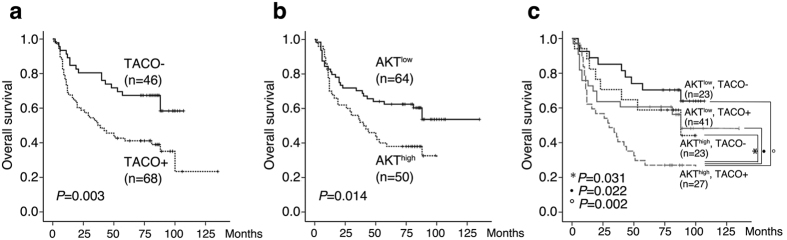
Association between postoperative survival, intrahepatic HBV CP mutations and pAKT levels.(a) Comparison of survival between patients with and without TACO mutations. (b) Comparison of survival between patients with different levels of pAKT. (c) Combination of intrahepatic TACO mutations and pAKT as a predictor for overall survival. TACO−: Negative for TACO; TACO+: Positive for TACO; AKTlow and AKThigh: low or high levels of pAKT.